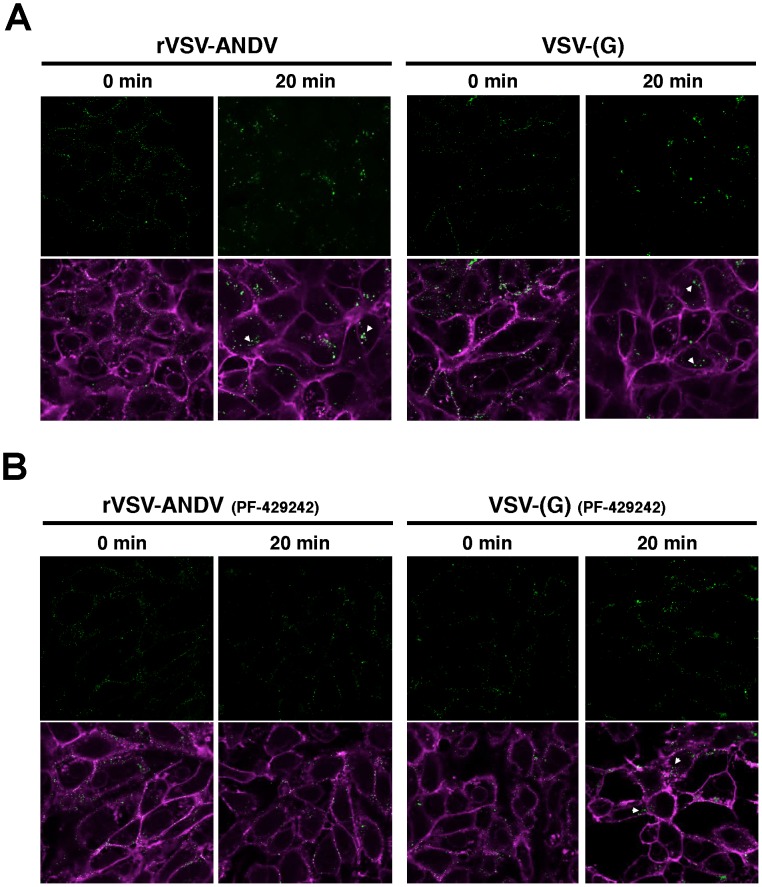
Detection of viral particles during cellular entry.Purified and DiO-labeled rVSV-ANDV (left) or VSV-(G) (right) where bound to Vero E6 cells at 4°C for 90 minutes pretreated for 24 hours with DMSO (A) or 40 µM PF-429242 (B). Cells were subsequently washed with cold PBS and fixed immediately (‘0 min’), or following a 20 minute incubation at 37°C, with paraformaldehyde. Cellular membranes where counterstained Wheat Germ Agglutinan-647 and imaged using confocal microscopy. Internalized virus is indicated with an arrowhead. Representative images from 2 independent experiments are shown.